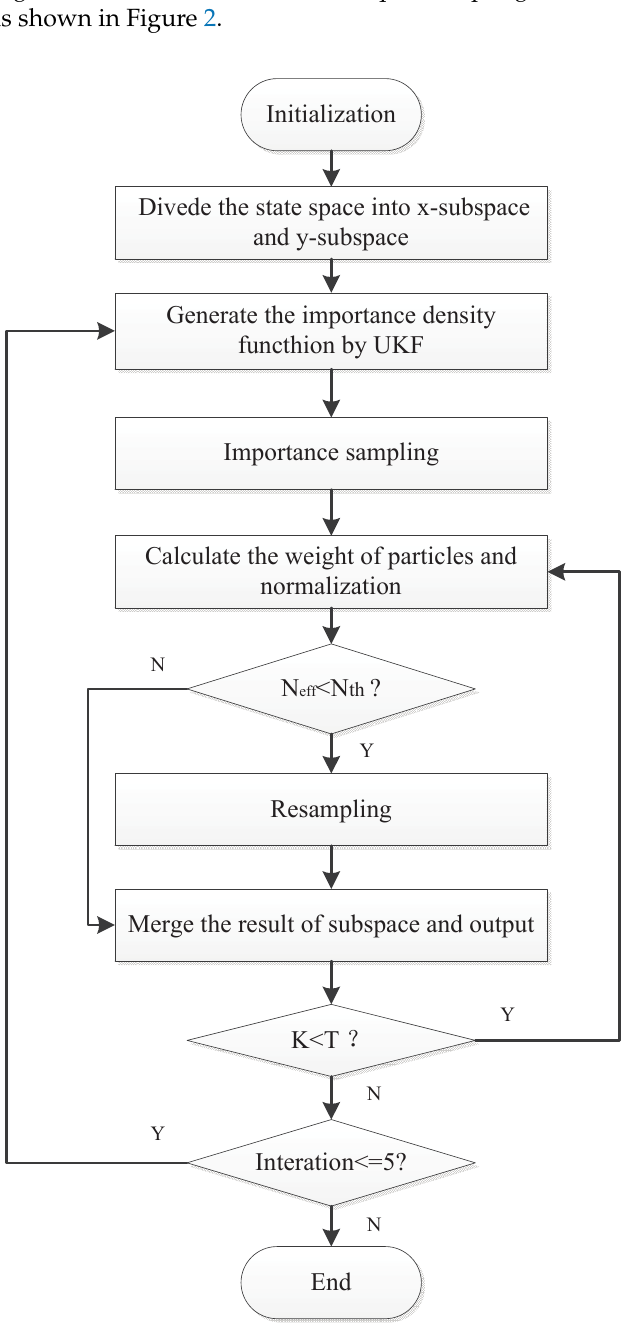
Figure 2. The flowchart of the divide-and-conquer sampling unscented particle